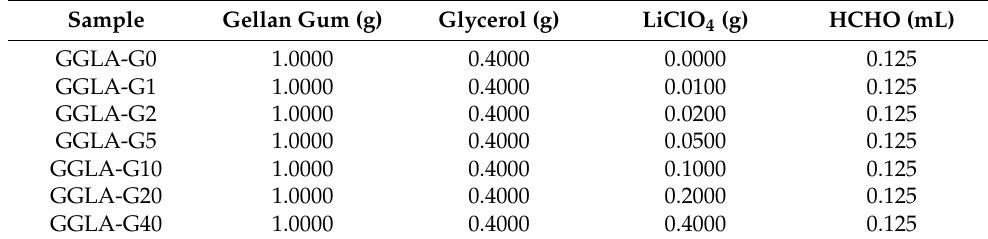
Table 9. Compositions of GGLA-based